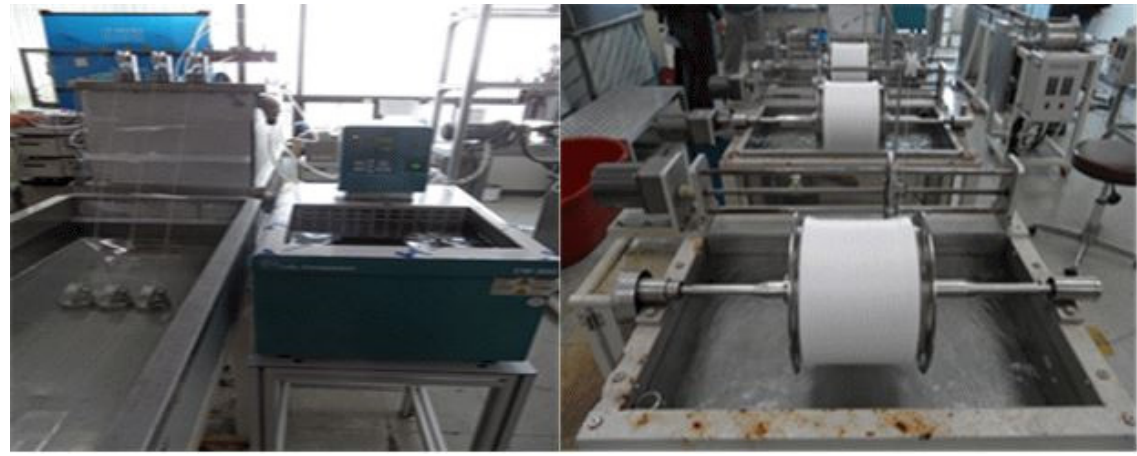
Figure 2. Production system for preparation of hollow fiber membrane.